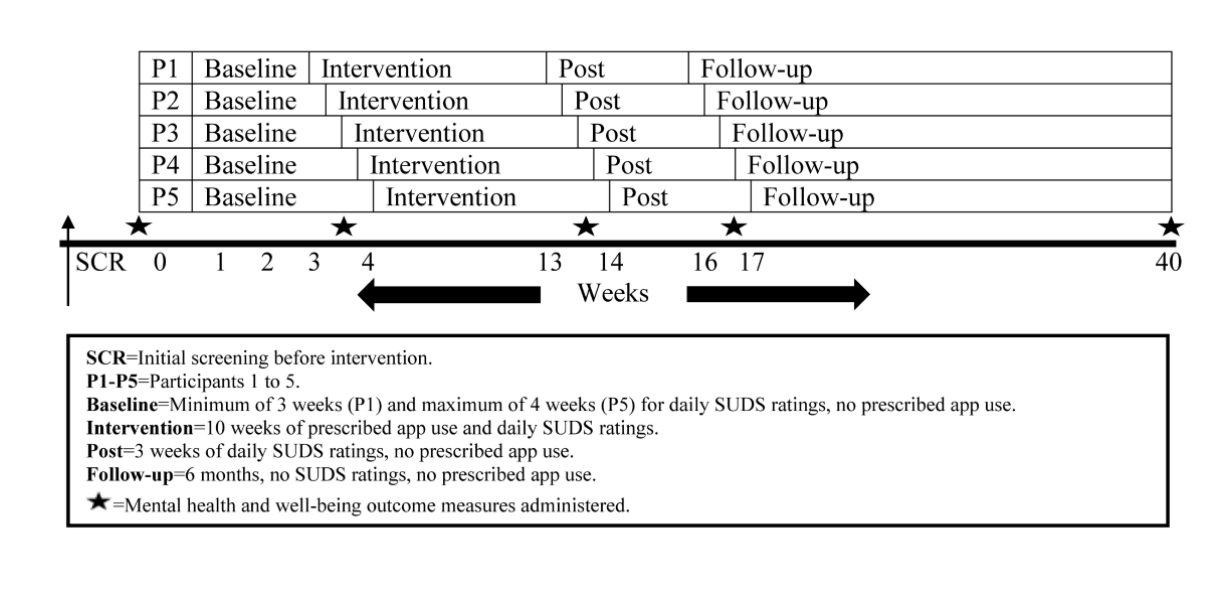
Figure 1. Overview of the proposed study